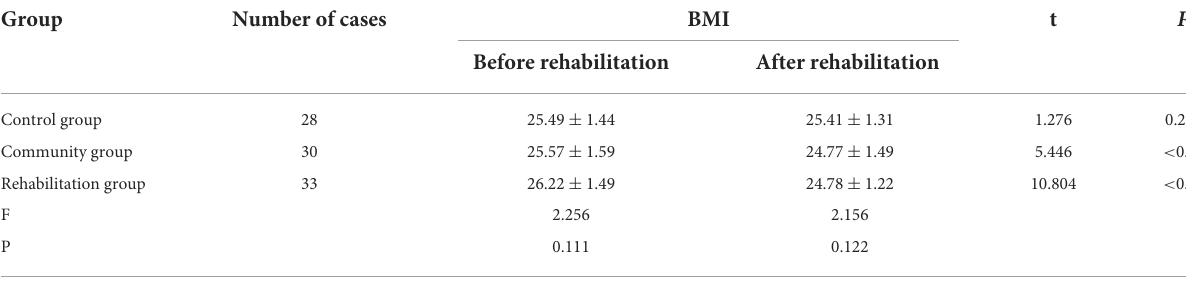
TABLE 7 Comparison of BMI of three groups of patients before and after rehabilitation. Group Number of cases BMI t P Before rehabilitation After